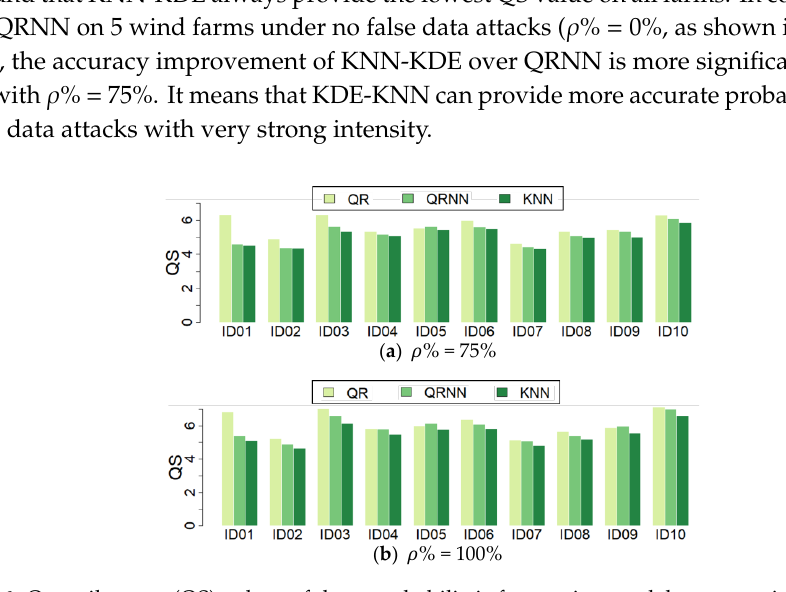
Figure 6. Quantile score ( QS) values of three probabilistic forecasting models on ten wind farms under various levels of false data attacks.